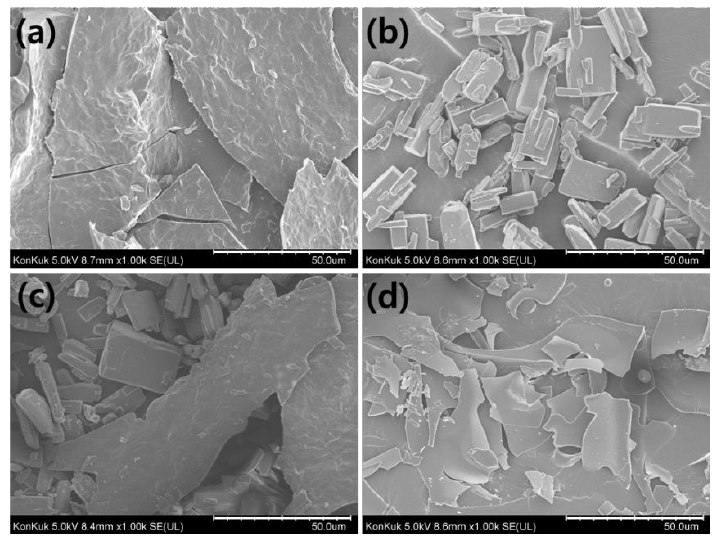
Figure 5. Scanning electron micrographs of ( a ) AEA–β–CD; ( b ) 5-chloroisatin; ( c ) their physical and ( d ) the inclusion mixture; and ( d ) the inclusion complex.